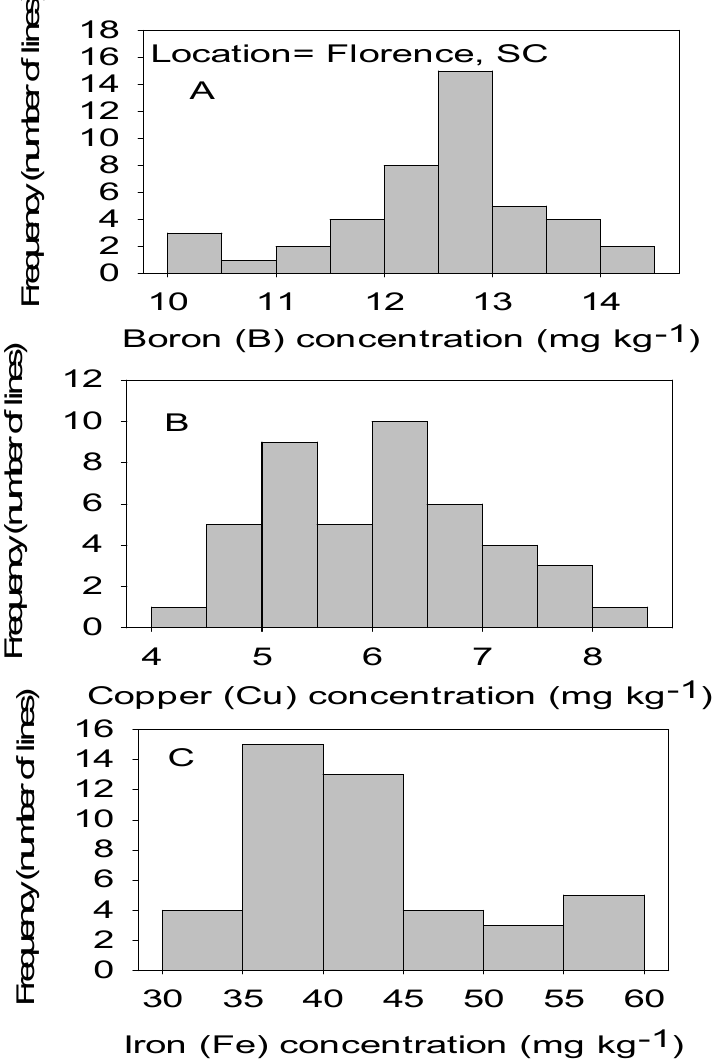
Figure 1. Distribution of micronutrients B ( A ), Cu ( B ), and Fe ( C ) in cottonseed in CS lines in cotton in Florence, SC, USA.